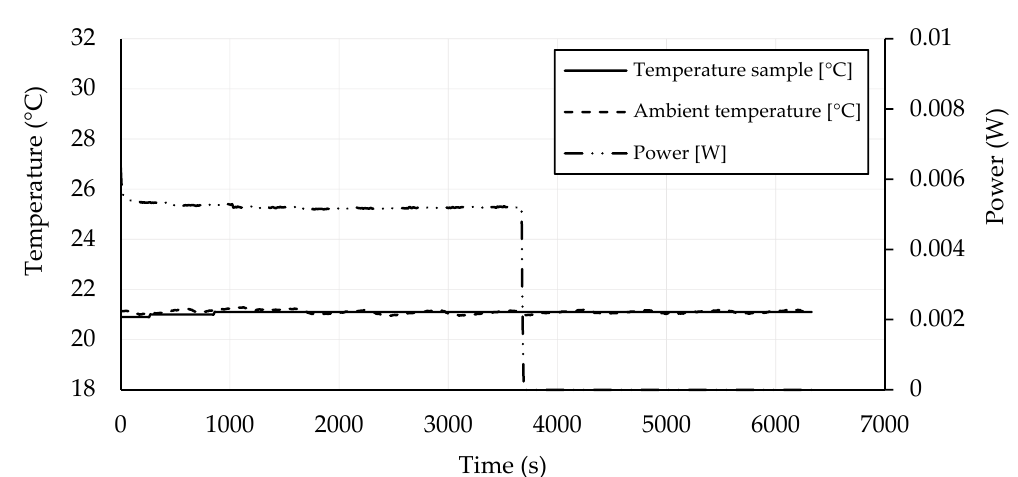
Figure 5. Self-heating experiment—CB 1.25, 40 V.